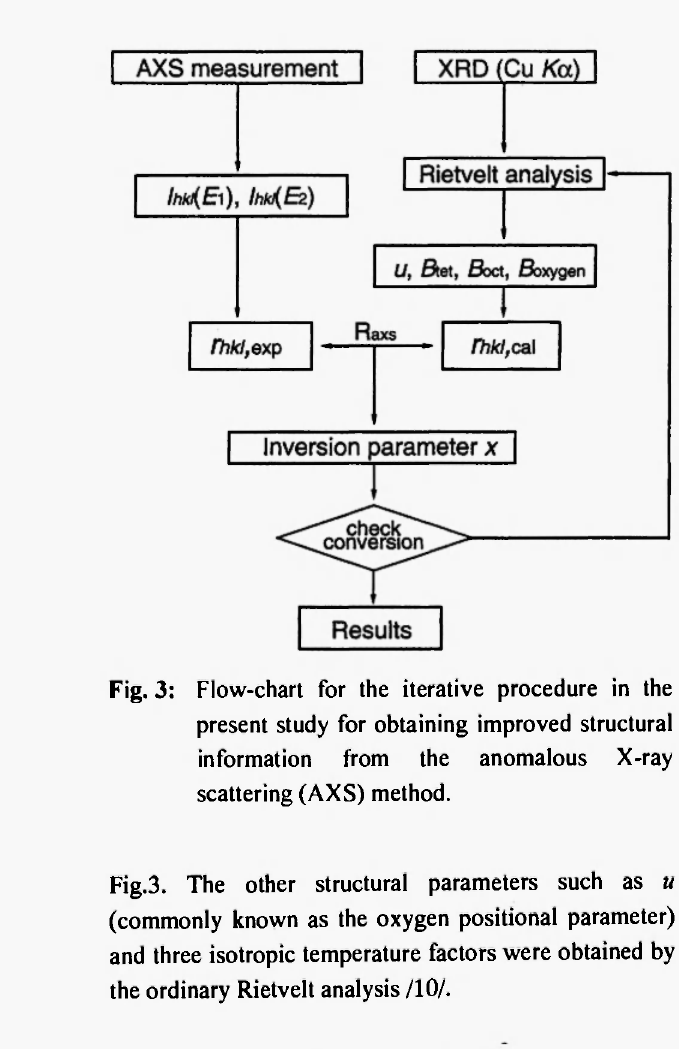
Fig.3. The other structural parameters such as u (commonly known as the oxygen positional parameter) and three isotropic temperature factors were obtained by the ordinary Rietvelt analysis